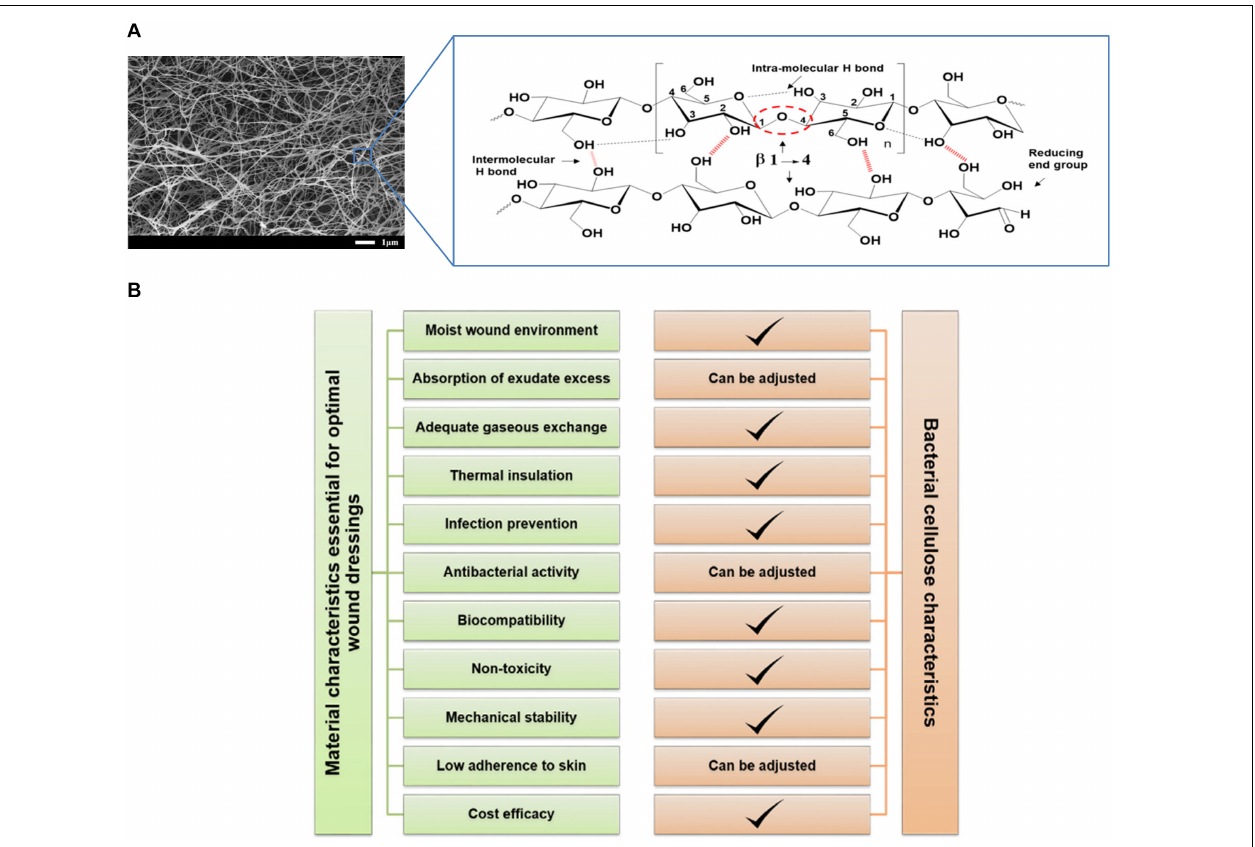
FIGURE 3 | (A) General introduction of BC tissue structure (Shao et al., 2016a; Tayeb et al., 2018). (B) An overview of BC characteristics with respect to the general requirements for wound dressing materials (Sulaeva et al.,